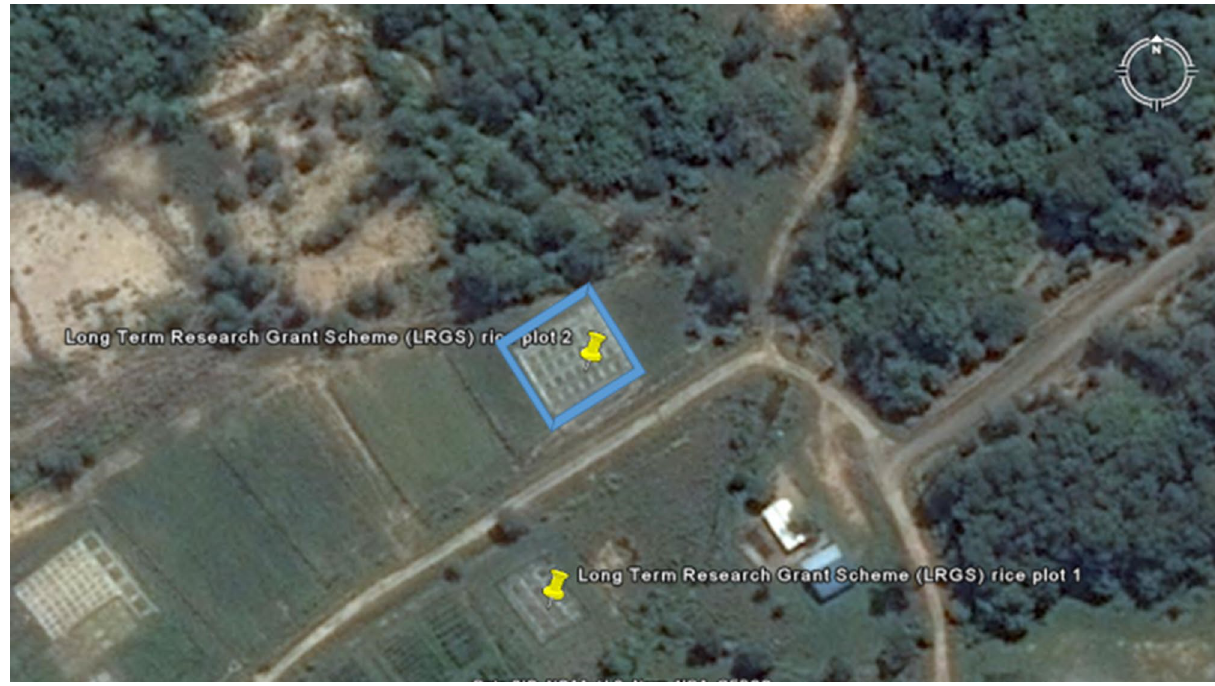
Figure 1. Aerial view of long-term research grant scheme rice plot